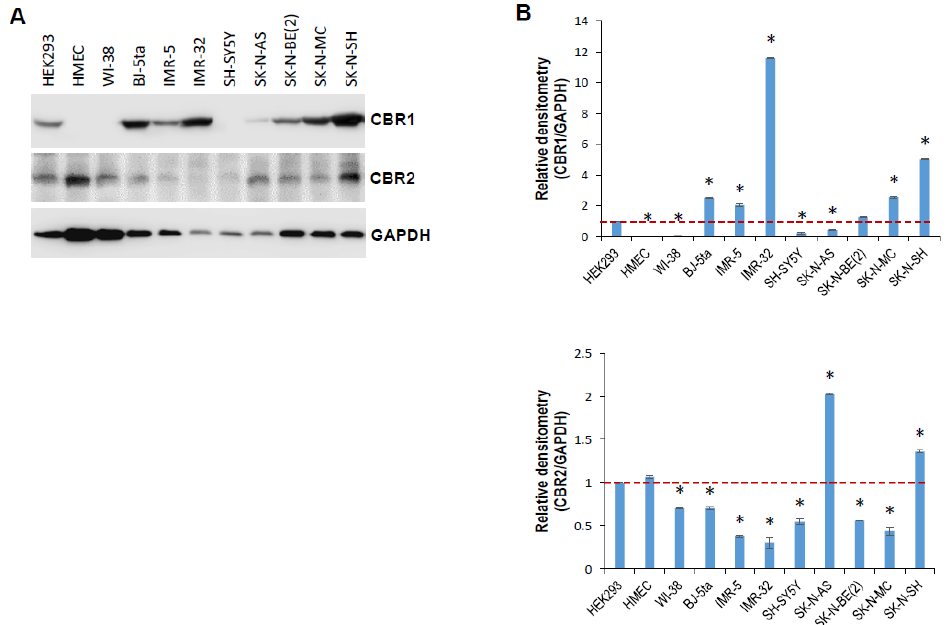
Figure 1. Expression of cannabinoid receptors CBR1 and CBR2 in normal and neuroblastoma cell lines. ( A ) Whole cellular lysates were prepared from indicated normal and neuroblastoma cell lines, and subjected to Western blot analysis using antibodies against CBR1 and CBR2 as described in Section 4; GAPDH served as a loading control. ( B ) Relative densitometry was measured using ImageJ, calculated as a ratio to GAPDH, and expressed as mean ± SD for three independent measurements. *, p < 0.05. Original western blot data is shown in Figure S3.